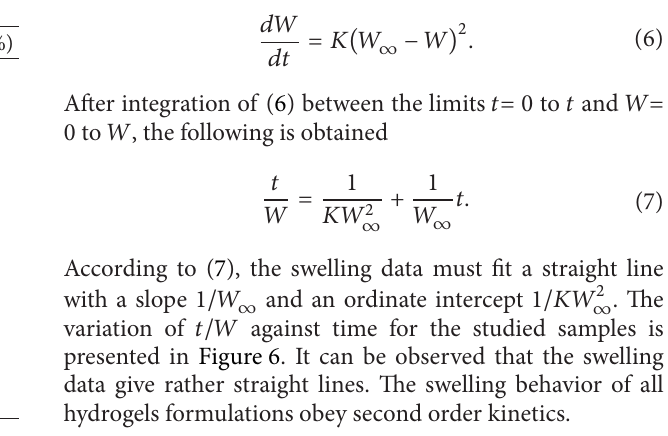
–AC ) 1a 5a –AC ) and chemically 1ab 5ab